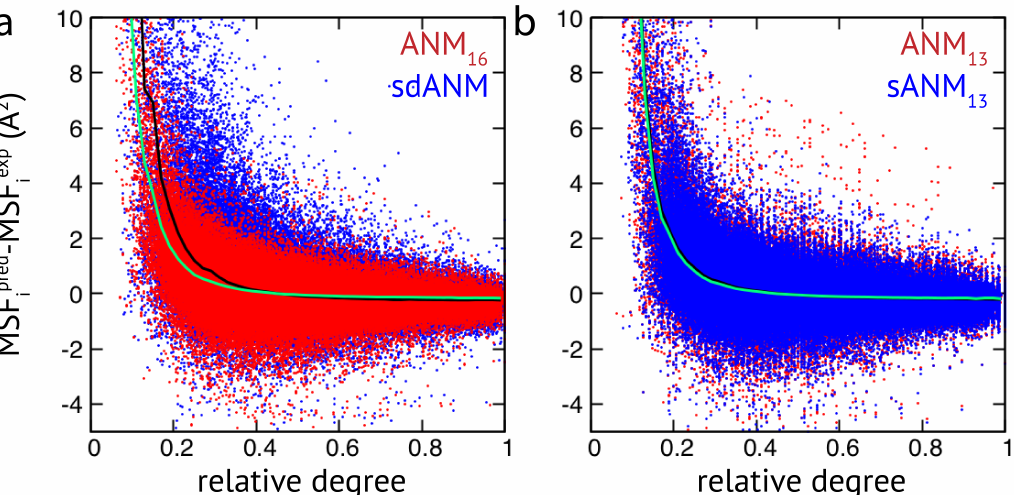
Figure A3. Extensive analysis of predictions by ENM variants. The error in MSF prediction for a set of more than 2000 protein structures is shown. Each data point represents the deviation of predicted and experimental MSF obtained for a single residue bead in a protein elastic network, as a function of its relative degree. ( a ) Red dots are obtained for ANM 16 and blue dots correspond to sdANM predictions. ( b ) ANM 13 is compared with sANM 13 . In both plots, the average errors are indicated as black lines for sANMs and as green lines for